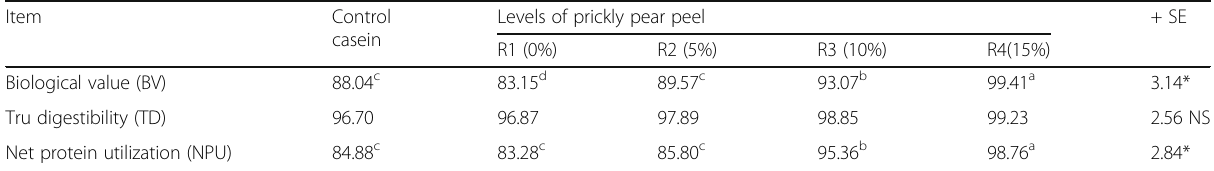
Table 7 Biological value, biological value, the tru-digestibility, and net protein utilization of commercial Cobb broiler meat-fed different levels of prickly pear peel powder